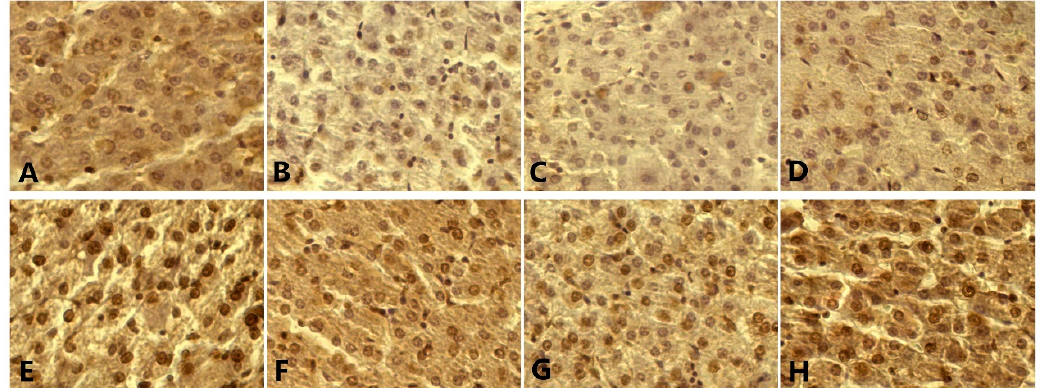
Figure 3. Apoptotic nuclei labeled (brown) with the TUNEL method. ( A ) Pigs fed a normal diet with 0 mg/kg Se; ( B ) pigs fed a normal diet with 0.3 mg/kg Se; ( C ) pigs fed a normal diet with 1.0 mg/kg Se; ( D ) pigs fed a normal diet with 3.0 mg/kg Se; ( E ) pigs fed a high-fat diet with 0 mg/kg Se; ( F ) pigs fed a high-fat diet with 0.3 mg/kg Se; ( G ) pigs fed a high-fat diet with 1.0 mg/kg Se; ( H ) pigs fed a high-fat diet with 3.0 mg/kg Se. Original magnification, ×400.